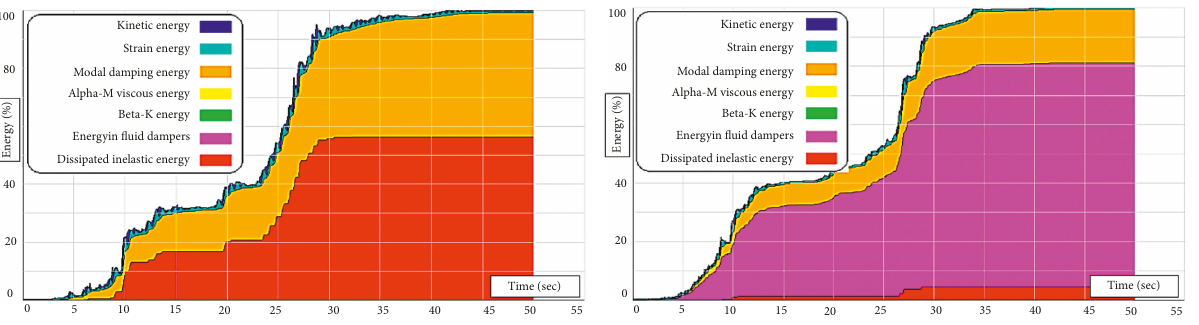
Figure 6: 4-story frame under record near Landers without and with dampers.